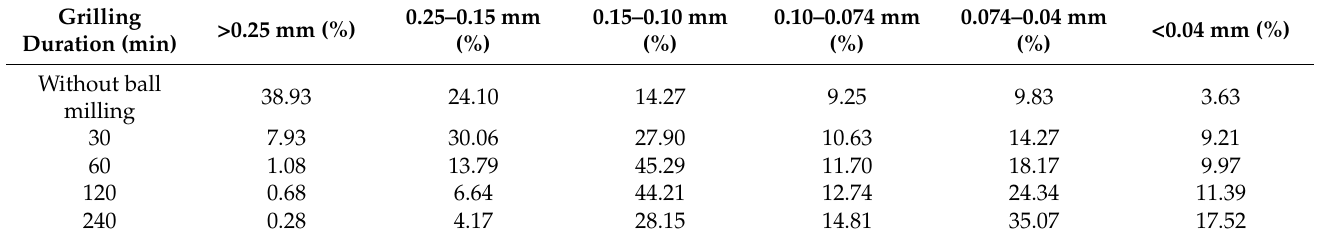
Table 11. Influence of the duration of the grinding process on the dissociation degrees of min- eral monomers.